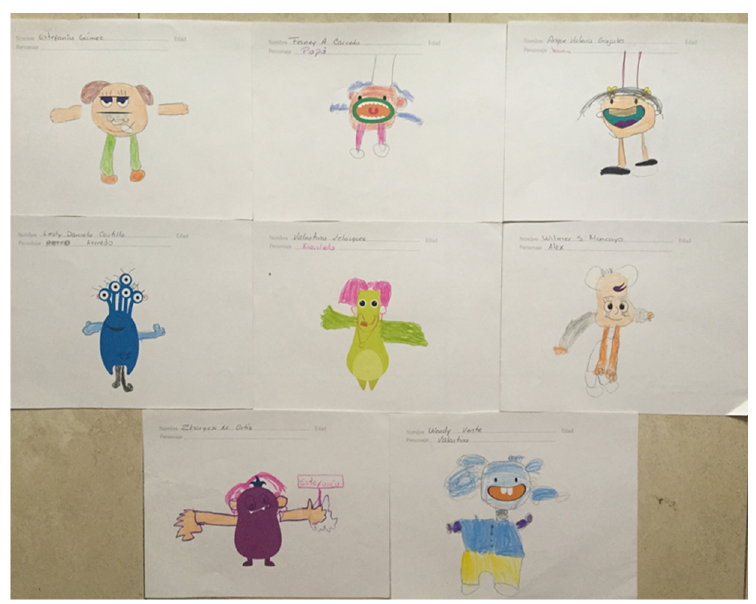
Figure 3. Drawing made by the pre-kindergarten children in the Institute of Blind and Deaf Children of Valle del Cauca.